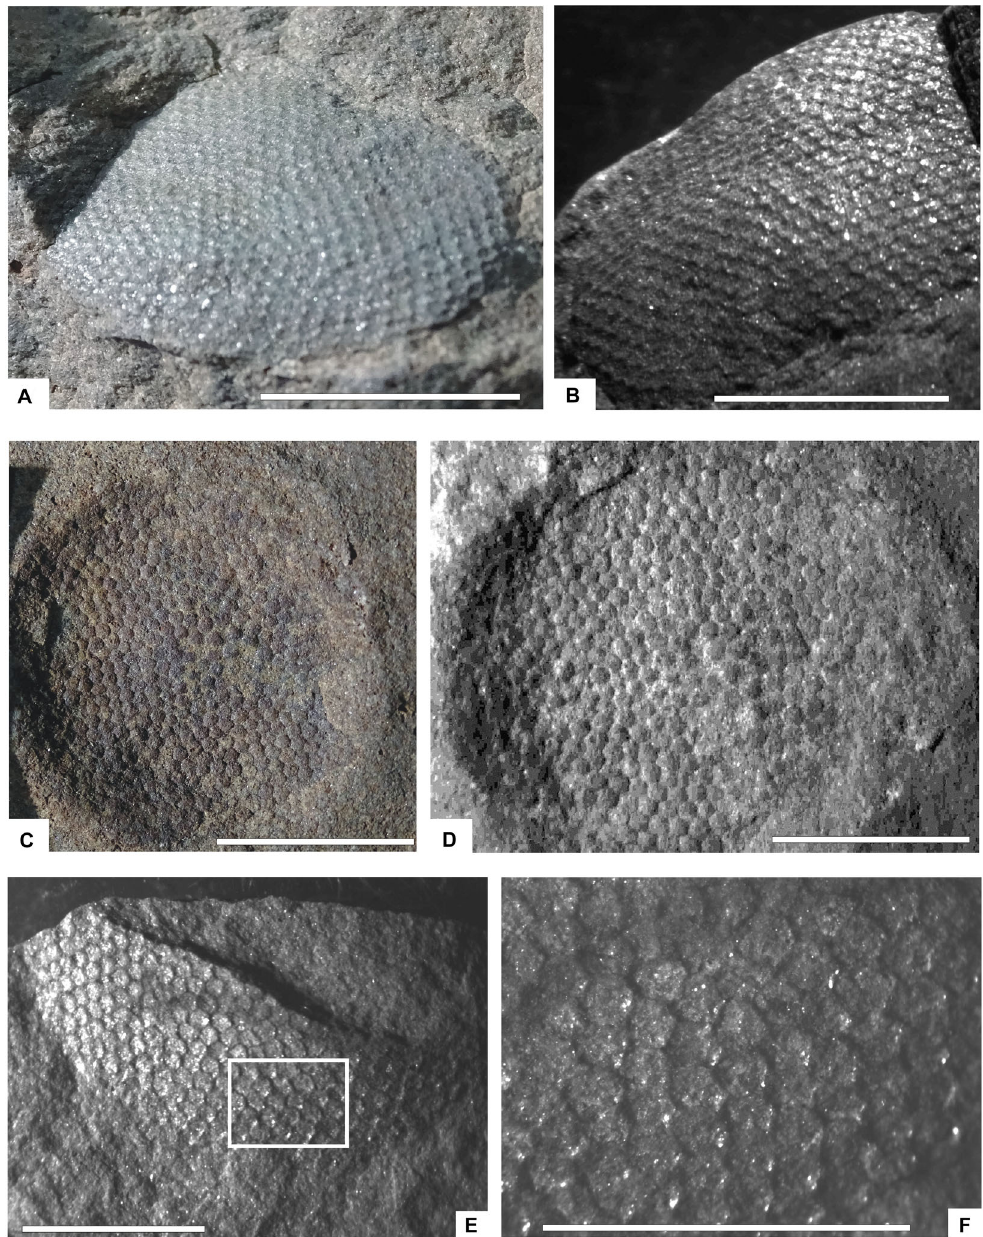
Fig. 4. Dasycladaceae algae Mastopora sp. ( A – F ) from the Takche Formation, Gechang locality, Parahio Valley, Spiti, Himalaya. F, magnification of E. All scale bars = 1